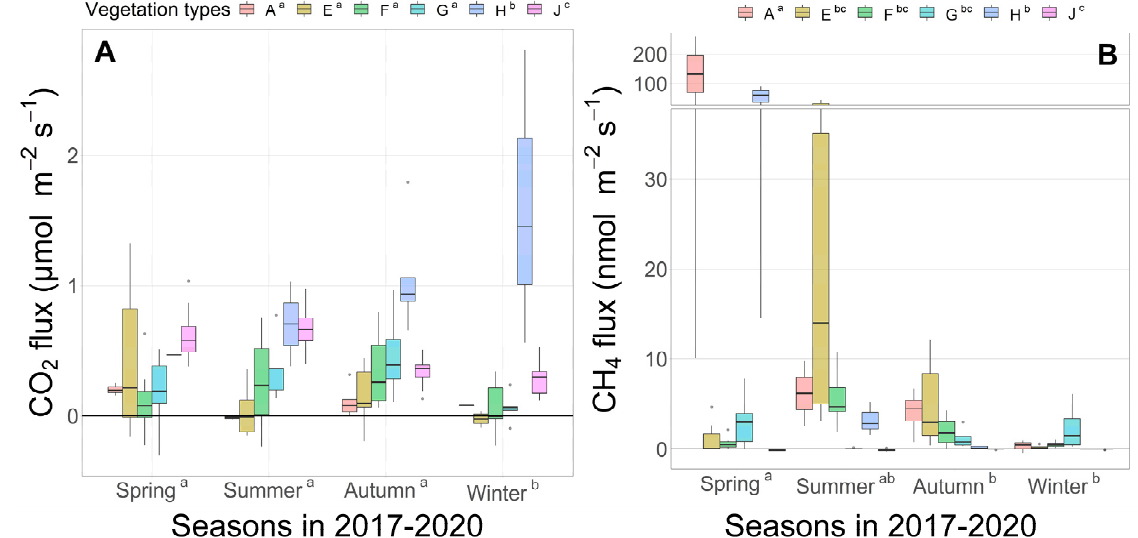
Figure 6. Soil CO 2 ( A ) and CH 4 fluxes ( B ) along the transect of changing vegetation types from the marsh to swamp forest at the YYL site (vegetation types A to H) and on a young yellow cypress forest (vegetation type J) 1.5 km away from the site. The measurements obtained between September 2017 and May 2020 were aggregated into four seasons. In each group of data (in total 24, i.e., six vegetation types × four seasons), values outside of the median ± 3 × median absolute deviation (MAD) were excluded before drawing the boxplots. Even though, there are still values that are shown individually for their extremity. The superscript letters indicate significant differences between categories (Tukey-HSD, p < 0.05). Table 1 presents the vegetation types.